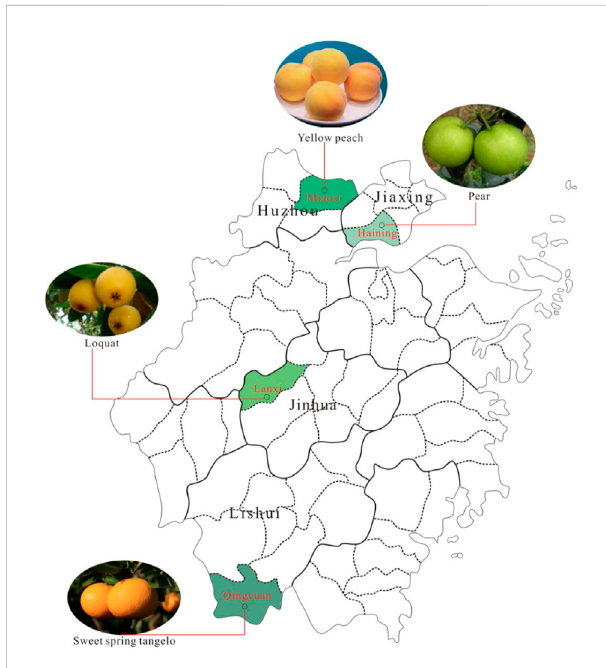
Sample collection from the four production areas in Zhejiang Province, China (n =